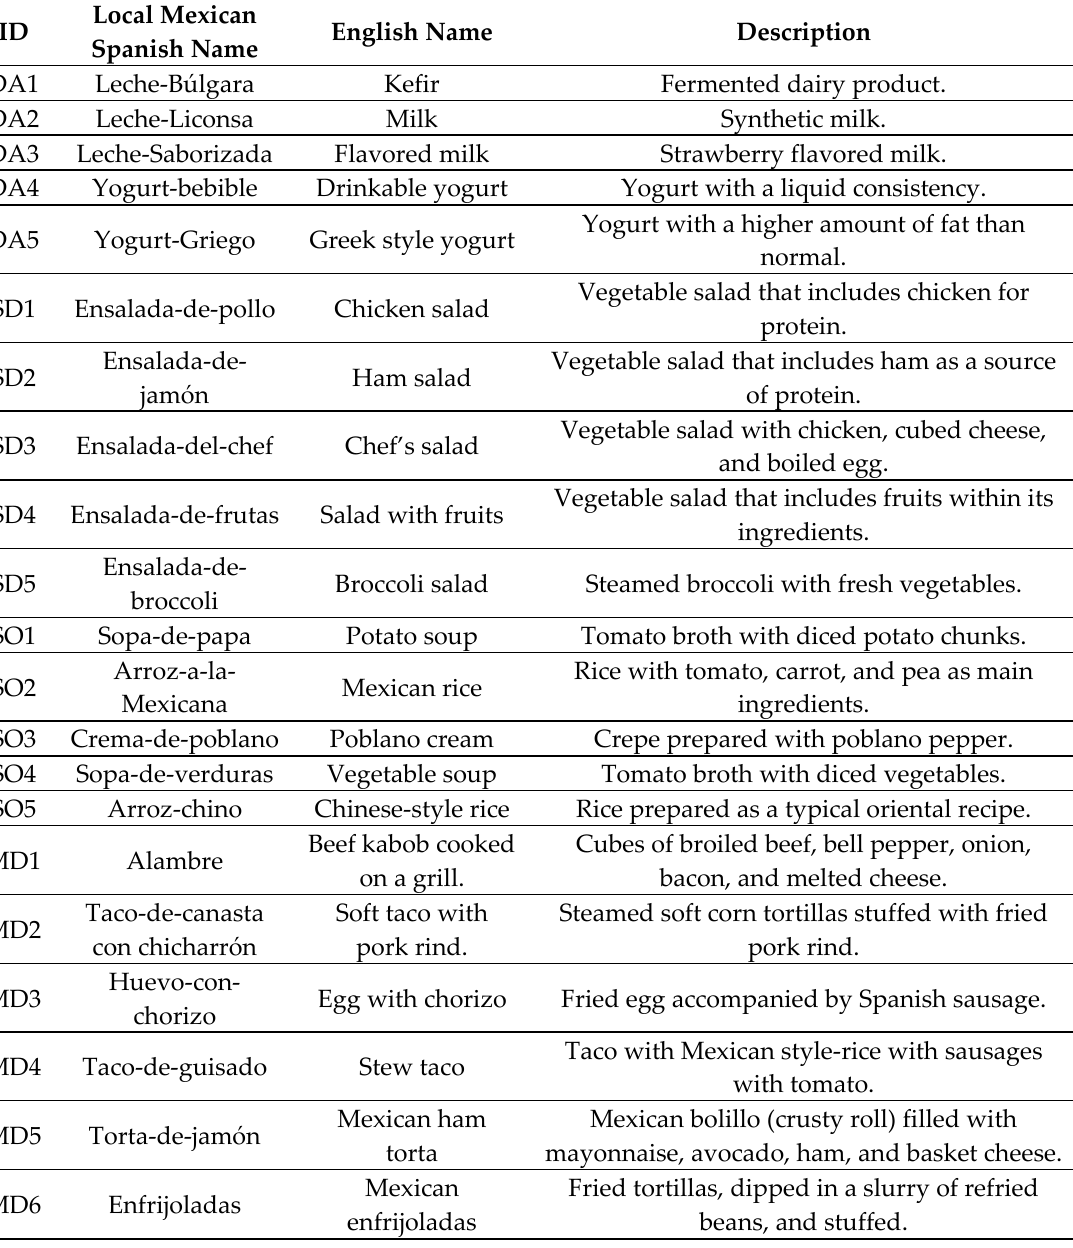
Table 1. Ready-to-eat